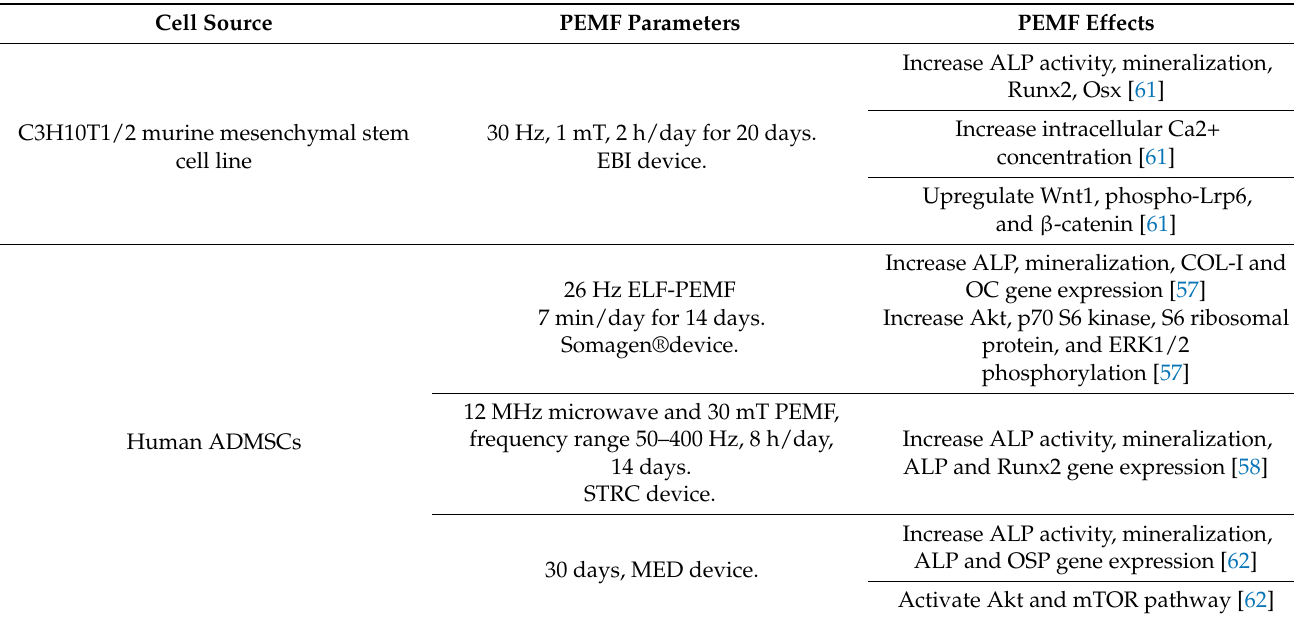
Table 2. Effects of pulsed electromagnetic fields on the osteogenic differentiation of mesenchymal stem cells (MSCs). Cell Source PEMF Parameters PEMF Effects